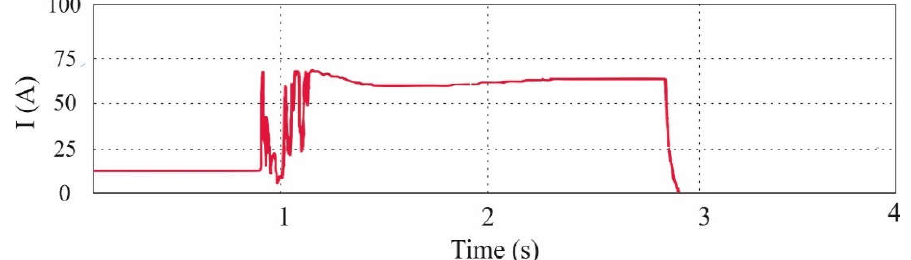
Figure 9. Current waveforms in the ATRU unit, based on the structure of a 24-pulse rectifier.